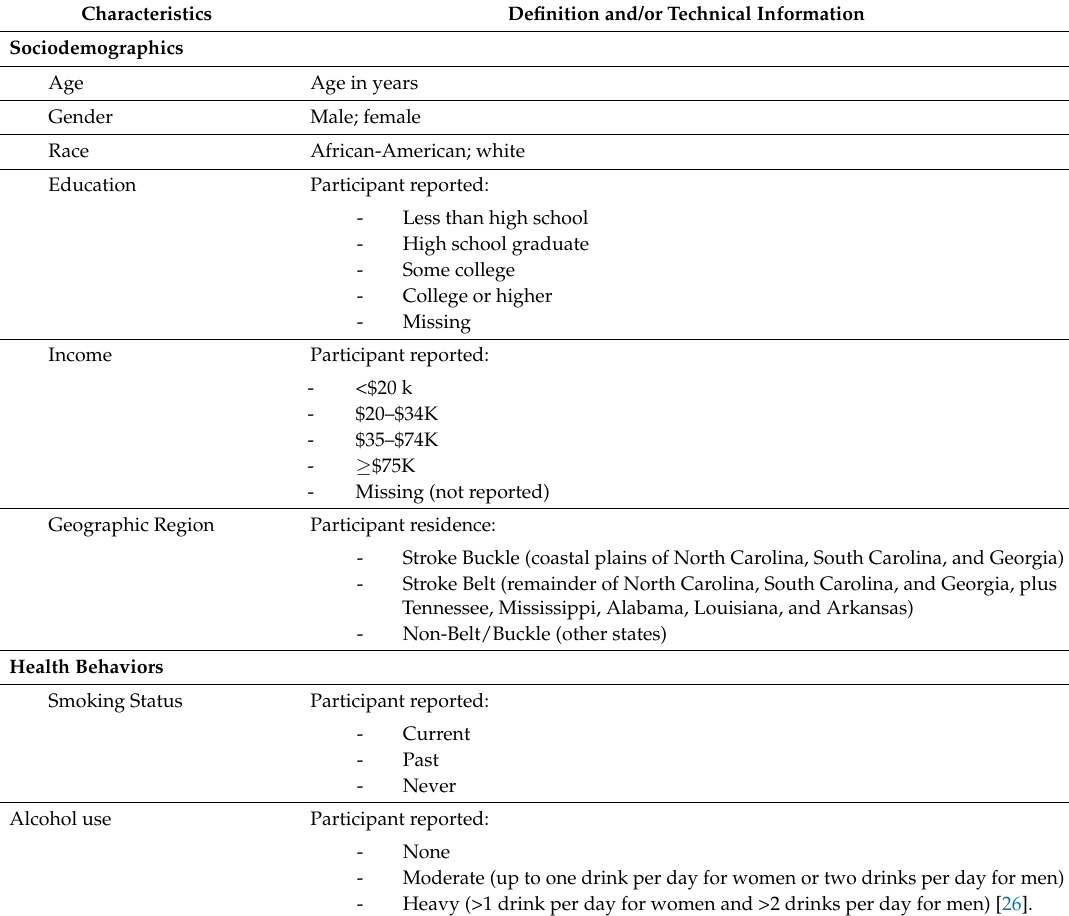
Table A1. Detailed definitions and technical information for sociodemographics, health behaviors, and chronic medical